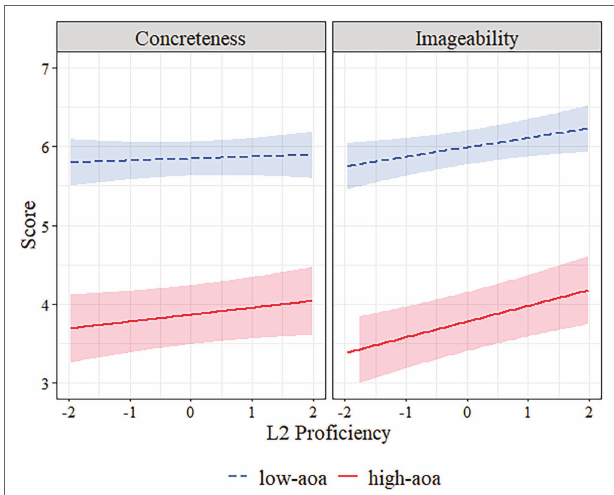
FIGURE 2 | The relationship between L2 proficiency and scaled scores of concreteness, imageability ratings of hi-lo AoA words. The hues around regression lines represent 95% confidence